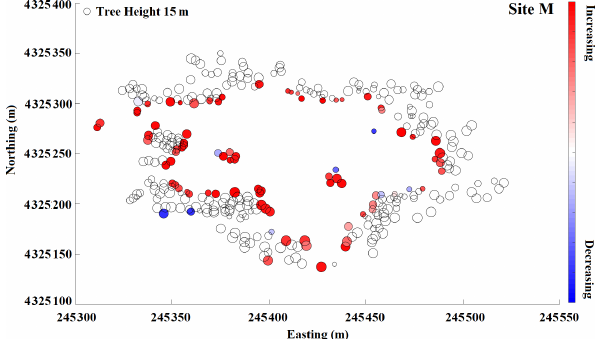
Figure B7. Snow depth change within a 10m buffer from the edge of a tree at site M. Red color indicates snow depth increases moving from the tree edge toward the open areas, and blue indicates snow depth decreases. Increasing and decreasing patterns are shown for individual trees at each site with adequate snow coverage.